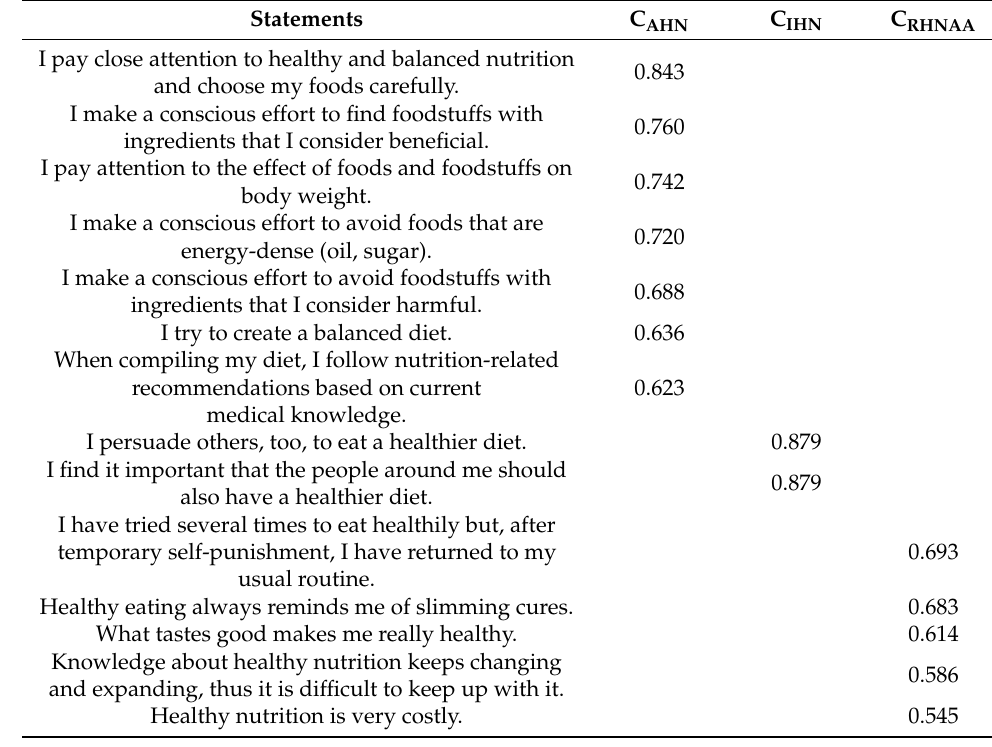
Table 5. Components of attitudes toward healthy nutrition and component weights.